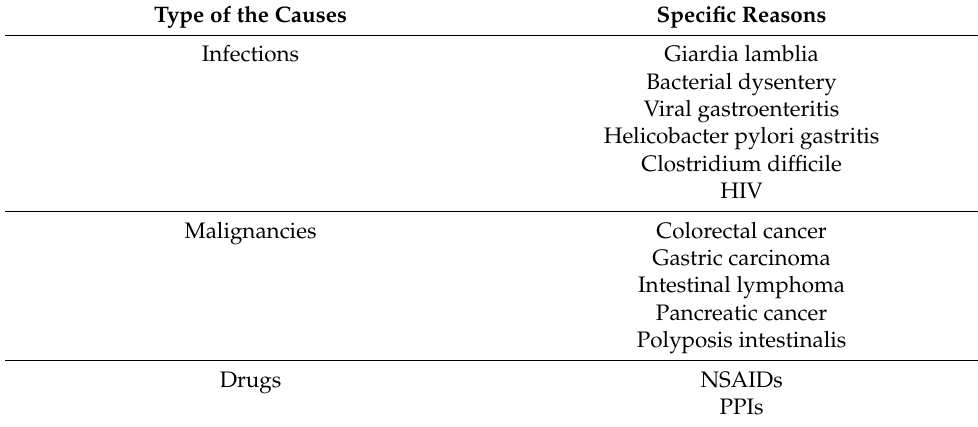
Table 5. Causes of abnormal results for fecal calprotectin other than inflammatory bowel